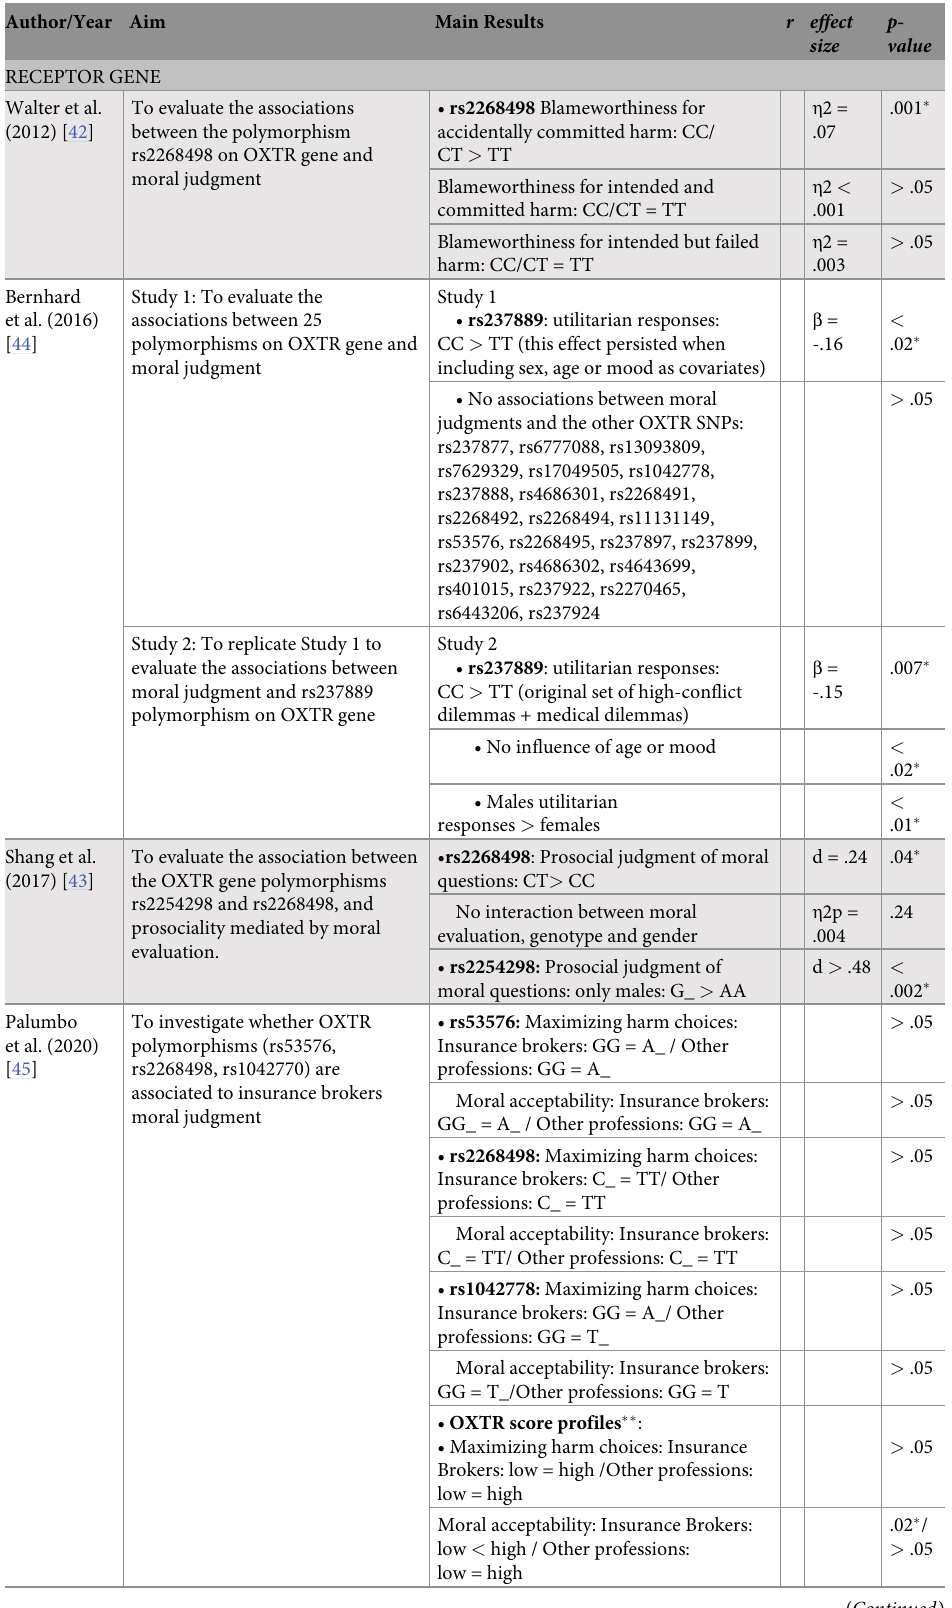
Table 3. Main results of the studies on oxytocin included in this